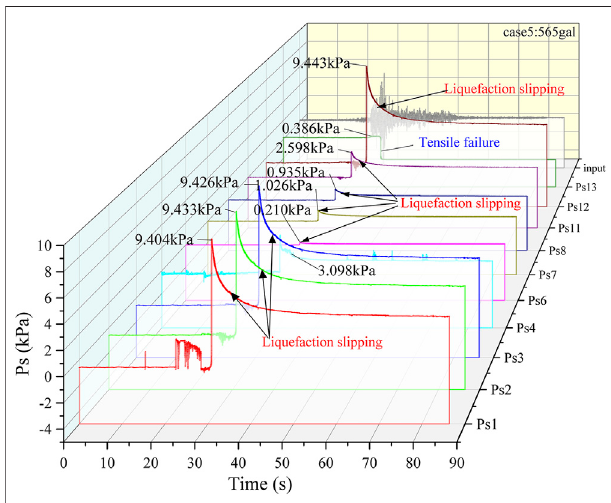
FIGURE 8 | The soil pressure in the slope when the peak acceleration of the input vibration is 565 gal.